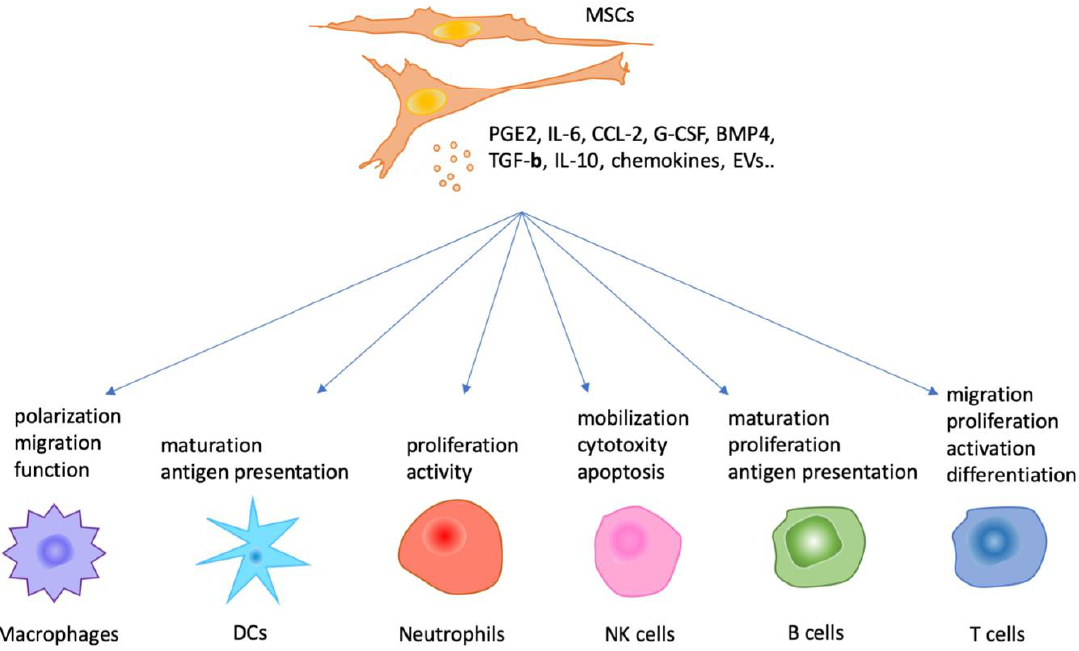
Figure1. Theregulatoryfunctionofmesenchymalstromal / Figure 1. The regulatory function of mesenchymal stromal/stem cells (MSCs) via paracrine on immune cells.